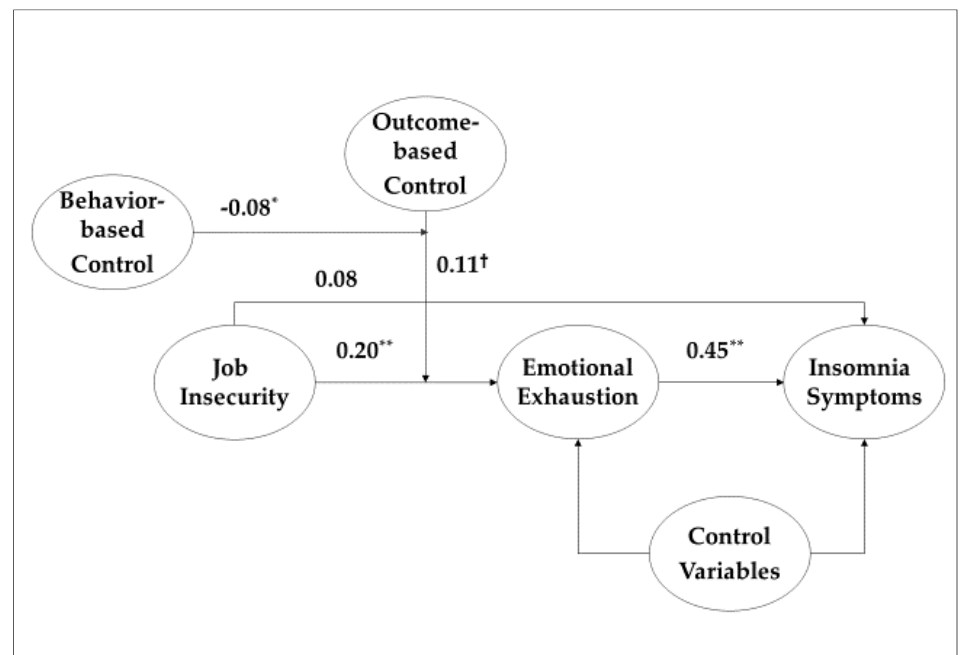
Figure 1. Moderated mediation model. Notes: † p < 0.1, * p < 0.05, ** p < 0.01. Coefficient: Figure1. Moderatedmediationmodel. Notes: † p < 0.1, * p < 0.05, ** p < 0.01.Coe ffi cient: unstandardized unstandardized coefficient. For parsimony, the control variables (i.e., gender, age, education, job coe ffi cient. For parsimony, the control variables (i.e., gender, age, education, job tenure, job status, tenure, job status, social desirability bias, and PANAS) are not included in this figure. social desirability bias, and PANAS) are not included in this